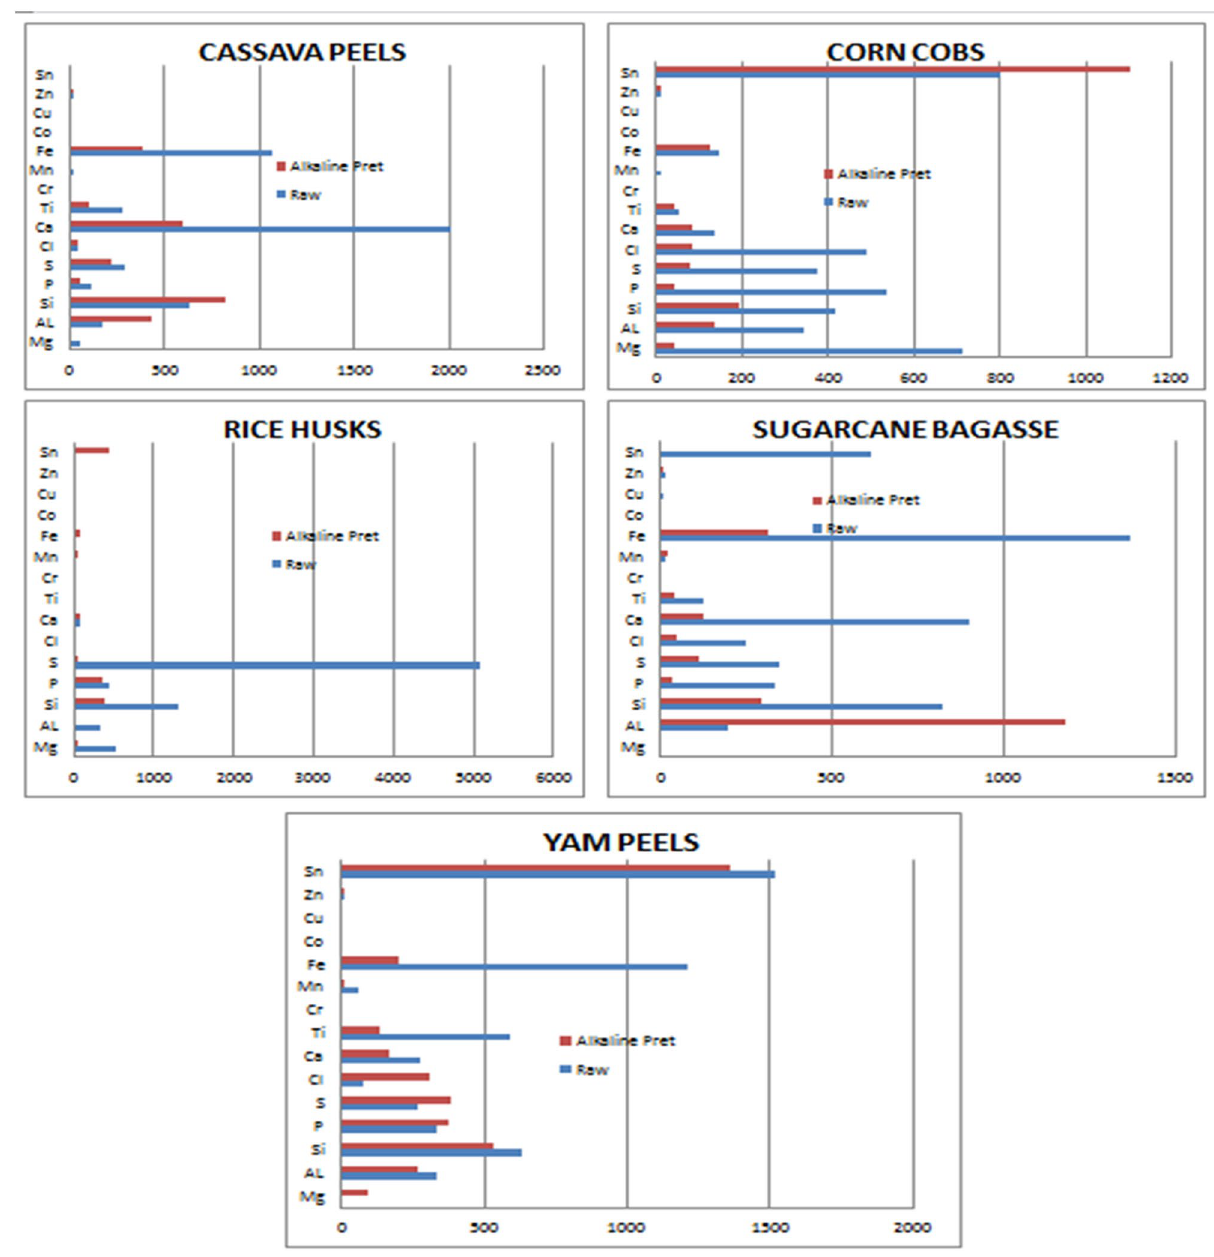
Figure 2. Effect of alkaline pretreatment for all single